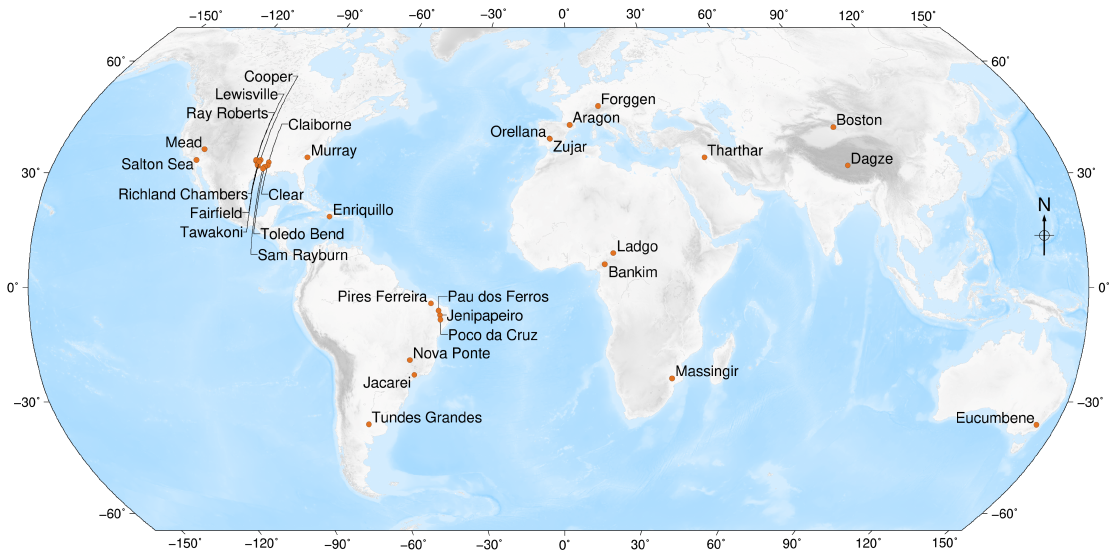
Figure 12. Map of selected and globally distributed study